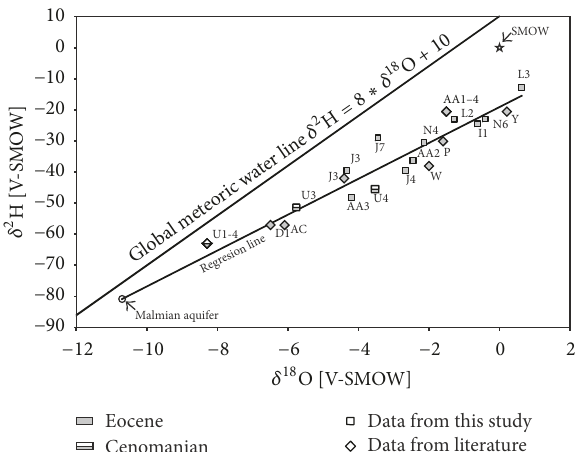
Figure 10: Cross-plots of 𝛿 2 H [V-SMOW] versus 𝛿 18 O [V-SMOW] values. Average isotopic values of Malmian aquifer are indicated after Andrews et al. [7], Goldbrunner [6], and Elster et al. [26]. For sample location, see Figure 1(c). According to Andrews et al. [7] and Goldbrunner [6], the regression line represents the mixing of connate brines and Malmian